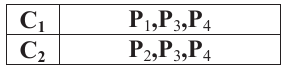
Fig 7. Normal Page